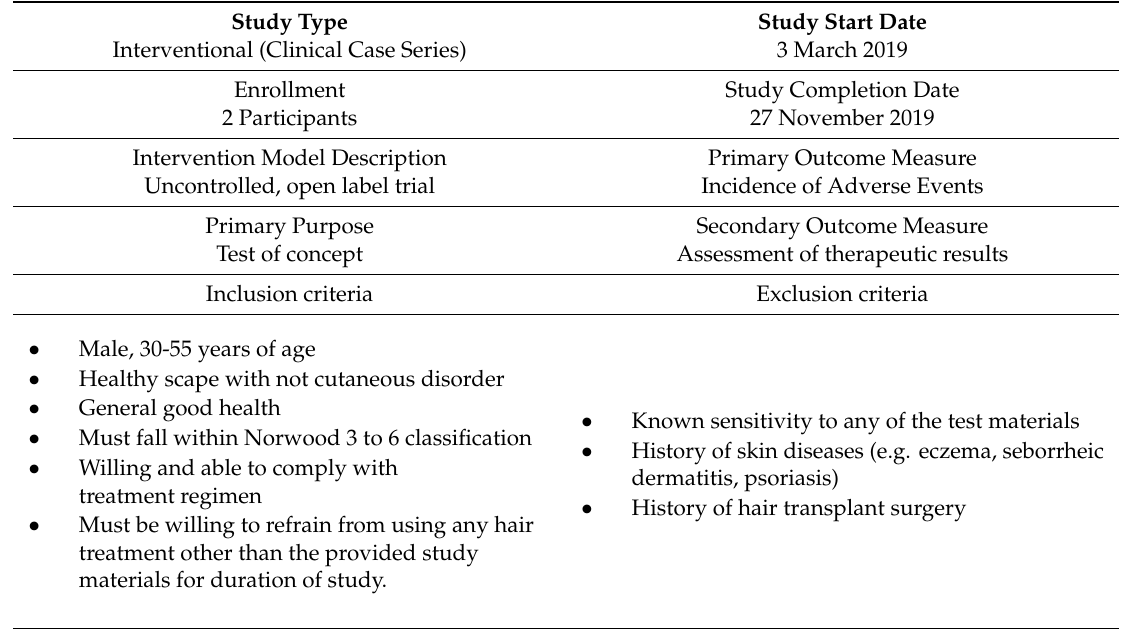
Table 2. Case series design and eligibility